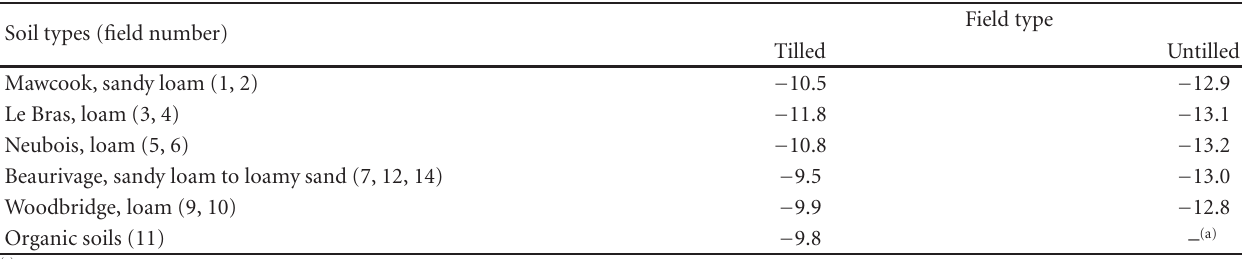
Table 7: Radar backscattering coe ffi cient thresholds (dB) used to di ff erentiate frozen from unfrozen soils taking soil and land use type into account over the Bras d’Henri watershed.